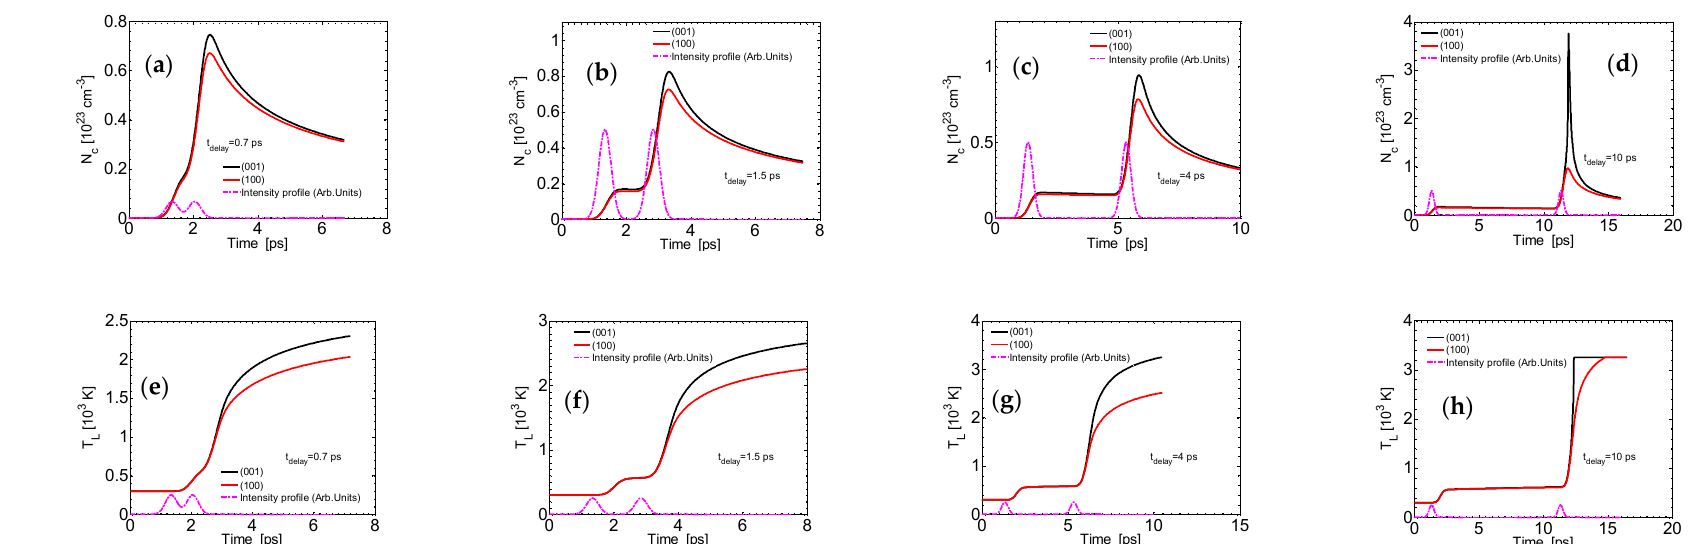
Figure 7. Evolution of maximum carrier density (first row) lattice temperature (second row)) for t delay = 0.7 ps ( a , e ), 1.5 ps ( b , f ), 4 ps ( c , g ) and 10 ps ( d , h ), respectively. ( E p = 10 mJ / cm 2 ) for (001) and (100) crystal orientation.